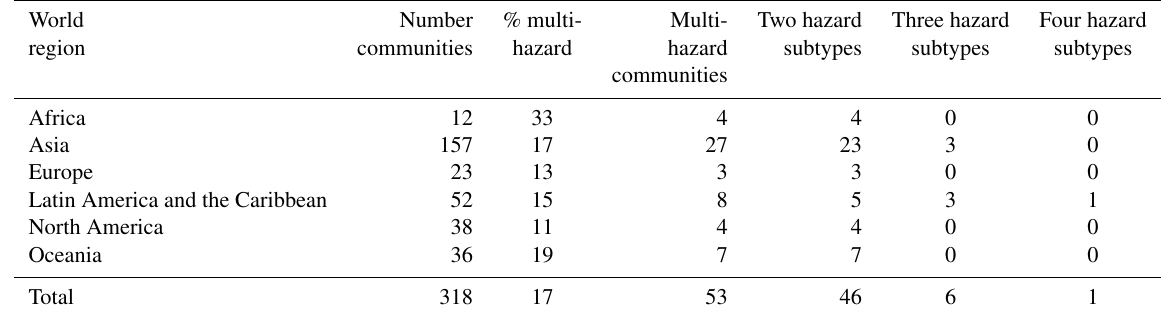
Table 5. Number of communities that are reported to have experienced more than one subtype of hazard. Information was reviewed for 318 communities from five regions of the